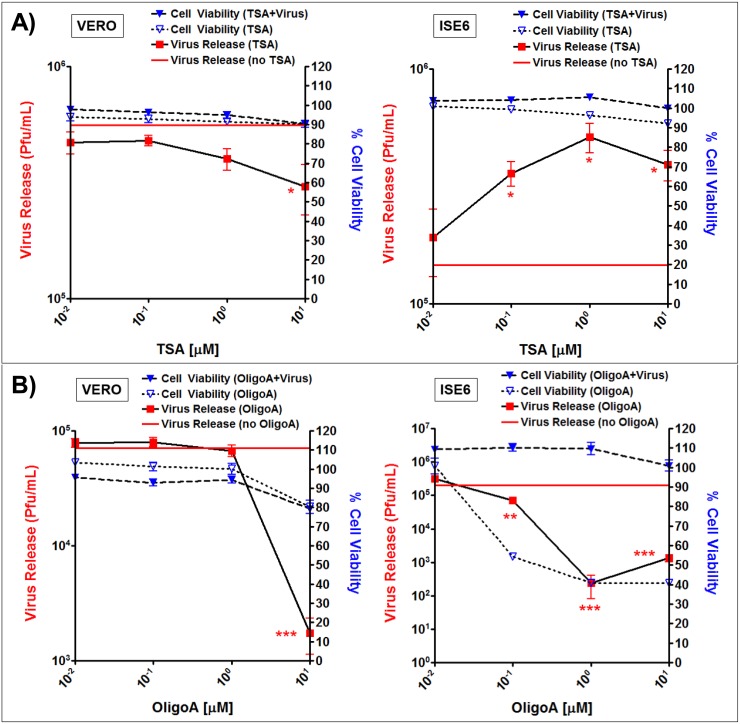
In vitro assays impact of (A) Trichostatin A and (B) Oligomycin A on LGTV replication.Trichostatin (TSA) and Oligomycin A (OligoA) concentrations on the x-axis, percent cell viability on the right y-axis, and virus release in pfu/mL on the left y-axis. Compound assays out of Vero cells are shown in the left panels and out of ISE6 cells are shown in the right panels. Release of LGTV was assessed by viral titer (pfu/ml) using plaque assays in BHK15 cells. Cell viability was determined with alamarBlue reagent and fluorescent assay and percentage was normalized against solvent only control in both LGTV-infected and mock-treated ISE6/Vero cells. * denotes p<0.05 and *** denotes p<0.001. Standard error shown in error bars with five technical replicates. Two biological replicate experiments were completed.